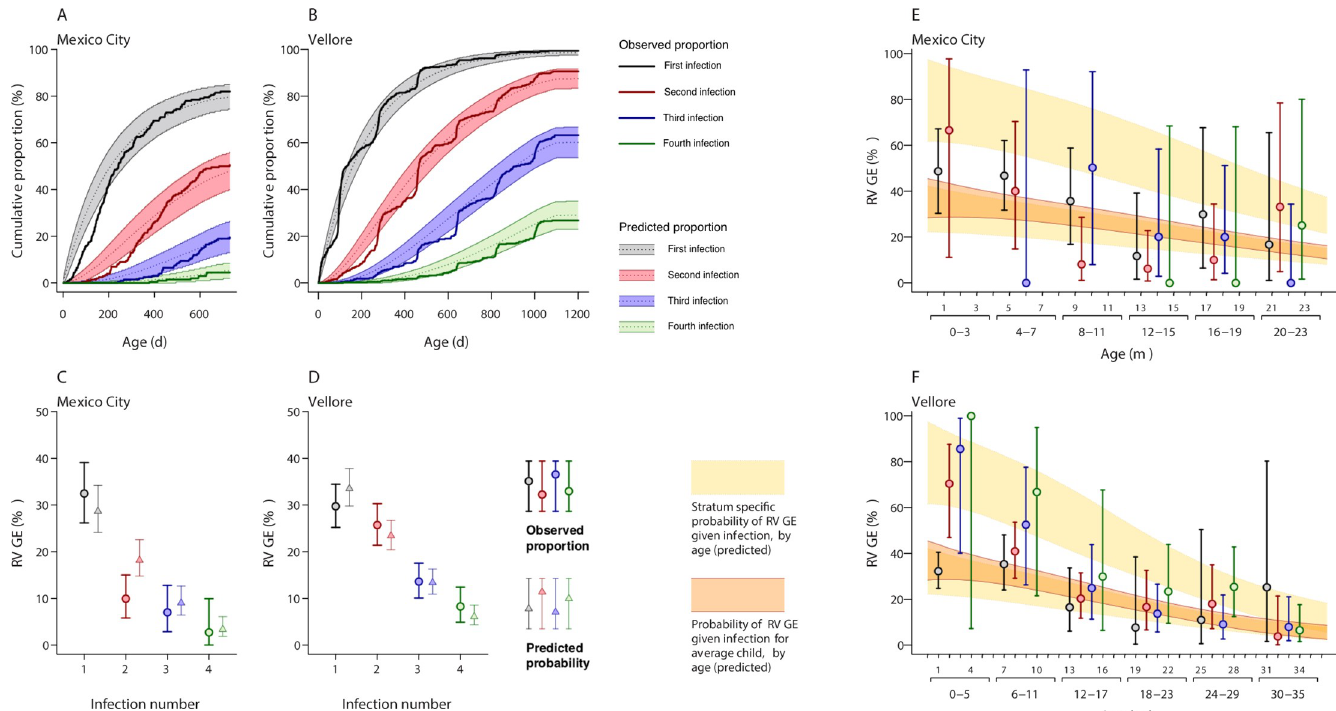
Fig 1. Natural history of rotavirus infection: Observations and model predictions. We plot cumulative incidence of first, second, third, and fourth rotavirus infections by age within the ( A ) Mexico City and ( B ) Vellore cohorts; shaded areas define 95% prediction intervals as fitted by the model, accounting for variation in risk among children and loss to follow-up, with dotted lines indicating median model predictions. ( C and D ) Observed proportions (circles, with 95% credible intervals) of infections involving RVGE, and model-predicted probabilities of RVGE given infection (triangles, with 95% prediction intervals), are plotted side by side. ( E and F ) We plot age-specific proportions of primary, secondary, third, and later infections involving RVGE (with 95% credible intervals); age strata within which such proportions are calculated correspond to the interval for serological sampling within the two cohorts (four months in Mexico City; six months in Vellore); these age bins are illustrated in the lower half of the x-axis. We superimpose these age-stratified estimates against the continuous decline in risk for infections to cause RVGE estimated by our fitted model (shaded peach); the lower estimate corresponds to the population of a low-risk sub-group ( R ), while the higher estimate corresponds to a higher-risk subgroup ( R C ) whose risk for RVGE, given infection, is increased by a factor ρ ( Table 1 ). The intermediate region (shaded orange) denotes risk for the average child within the cohorts. Shaded areas denote 95% prediction intervals around estimates of age-specific